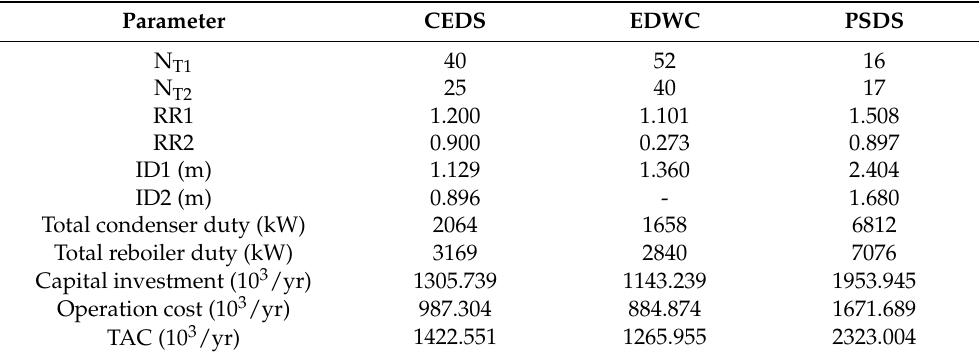
Table 1. Optimization results of CEDS, EDWC and